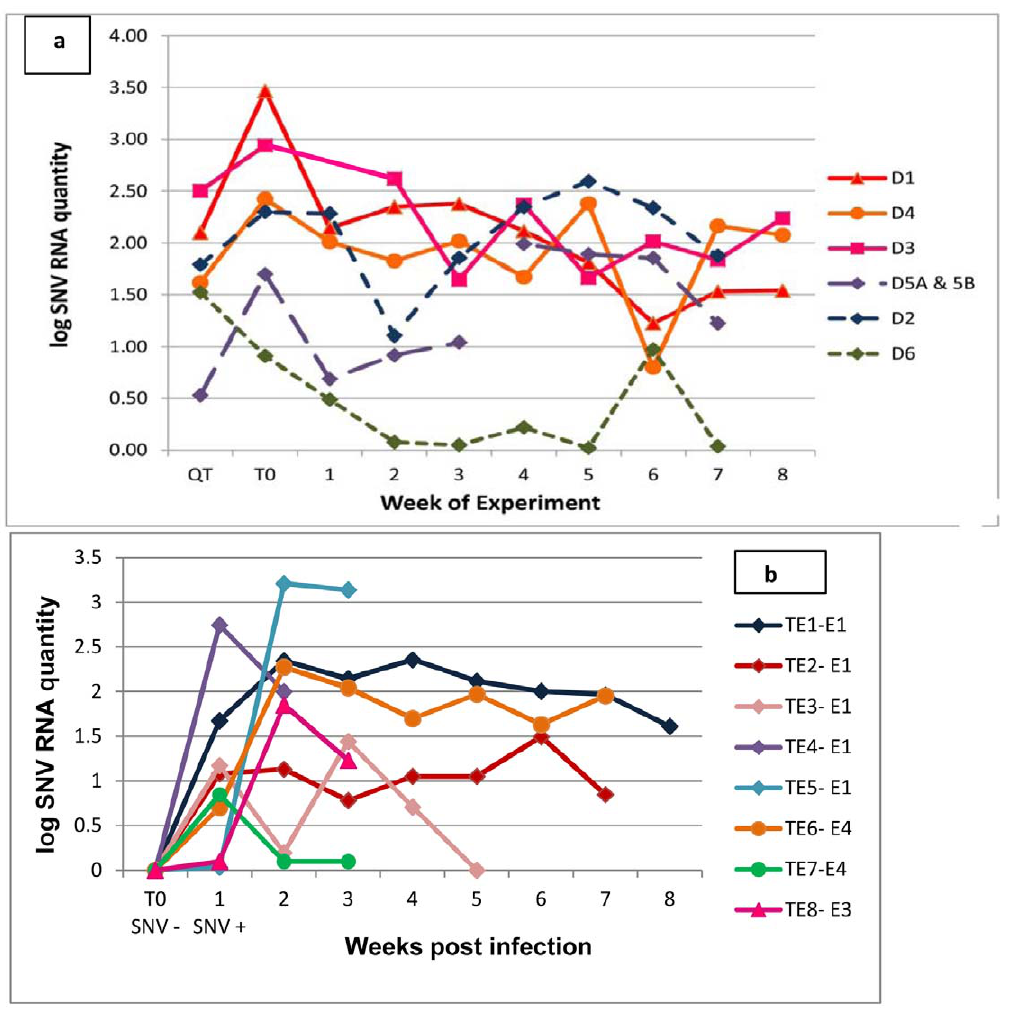
Figure 1. Sin Nombre hantavirus (SNV) RNA levels for (a) donor deermice before and during experiment 4, and (b) transmission event (TE) deermice at time zero (T0) and during experiment 4. a) We recovered the remains of the original donor (D5a) in enclosure 5 on week 4, and substituted a new donor (D5b). Insufficient sample was collected from donor 3 on 8/1/08 for qRT-PCR analysis. Viral RNA was quantitated from all blood samples collected starting at initial capture from the wild (QT) until the end of the experiment. b) E1, E4, and E3 are the enclosures in which each TE deermouse became infected. T0 represents the last blood sample negative for both SNV RNA and antibody to SNV before SNV RNA was first detected. Testing blood samples included retesting the initial SNV-positive sample (as indicated by prior serology or nested RT-PCR) and all subsequent blood samples, as well as blood collected at 2 or more timepoints before the initial positive test. SNV RNA quantities are proportional (see Methods), not actual copy